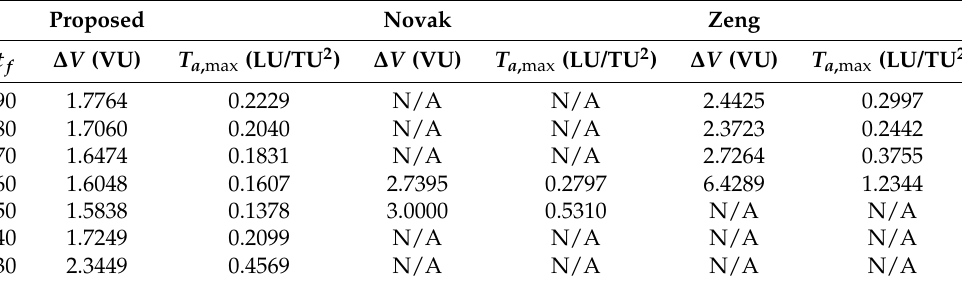
Table 3. Orbit rendezvous results with different t f when r 1 < r 2 .